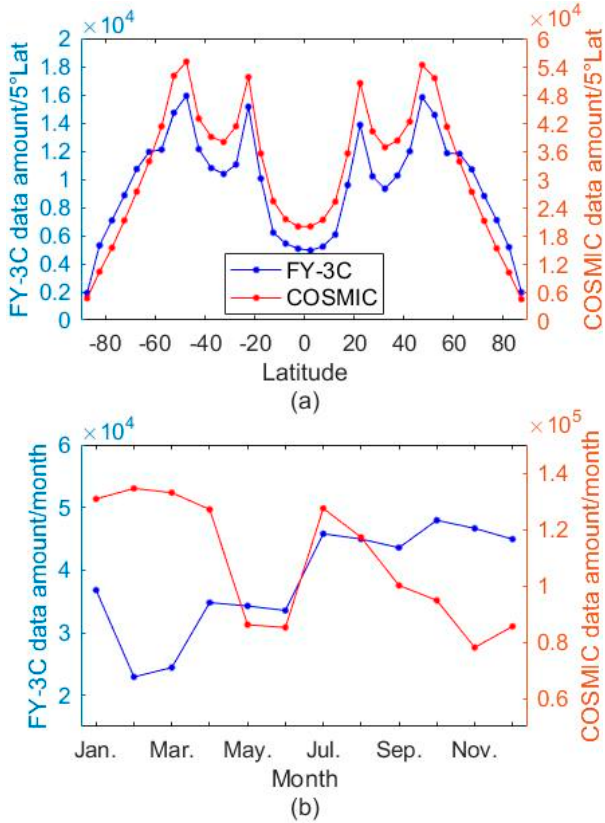
Figure 1. Latitudinal ( a ) and temporal ( b ) distribution of 4 years of FY-3C (blue dot) and COSMIC (red dot) temperature profiles.